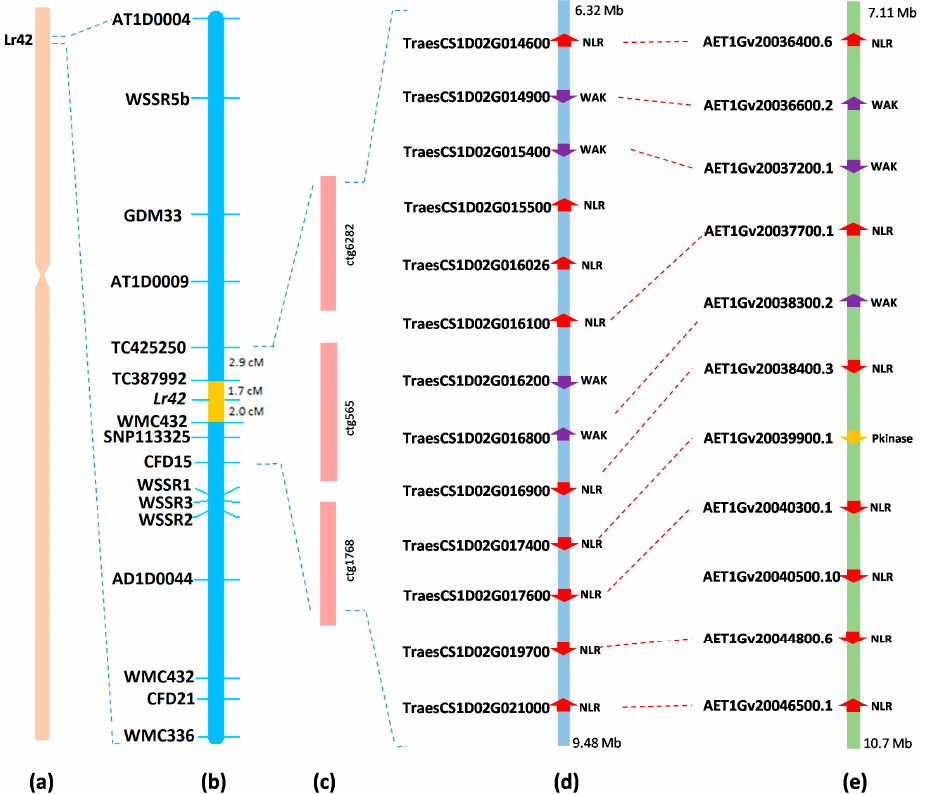
Figure 3. Candidate genes in the Lr42 region in wheat and Ae. tauschii . ( a ) Physical location of Lr42 on chromosome 1DS of wheat; ( b ) genetic location of Lr42 in KS93U50 / Morocco F5 RIL; ( c ) BAC contigs spanning the Lr42 physical region; ( d ) annotated genes in the Lr42 region in CS RefSeq v1.1 [22]; ( e ) annotated genes in the Lr42 region in the Ae. tauschii chromosome 1 sequence [21]. NLR: nucleotide-binding leucine-rich repeats; WAK: wall-associated kinase; Pkinase: protein kinase.